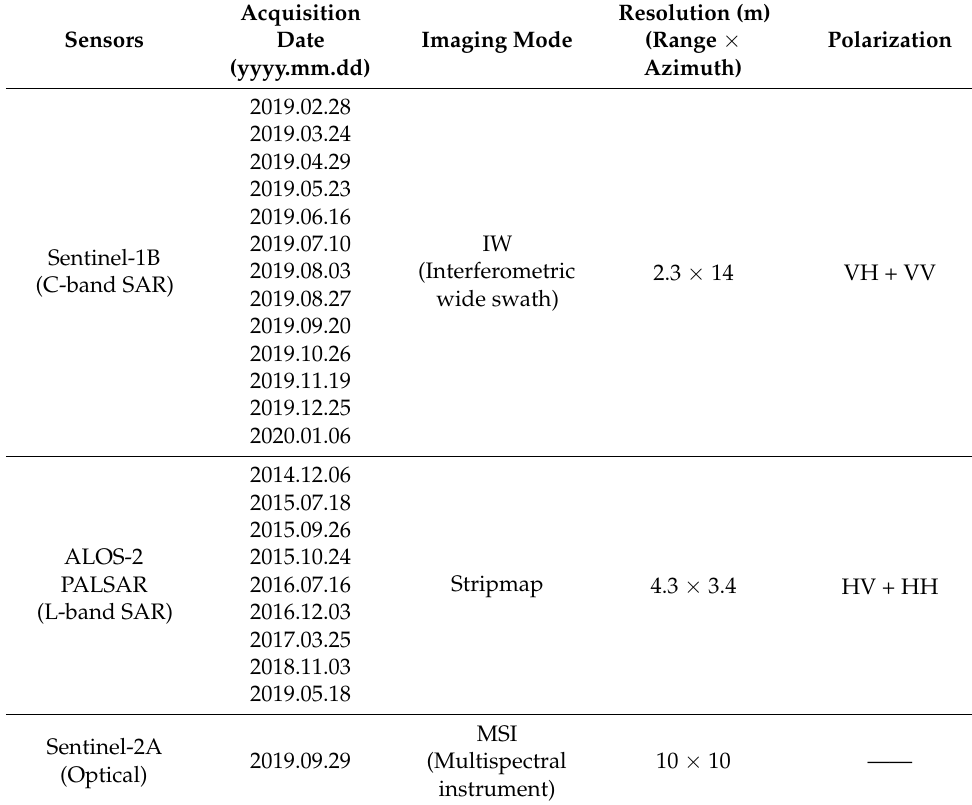
Table 1. SAR and optical remote sensing imagery used in this